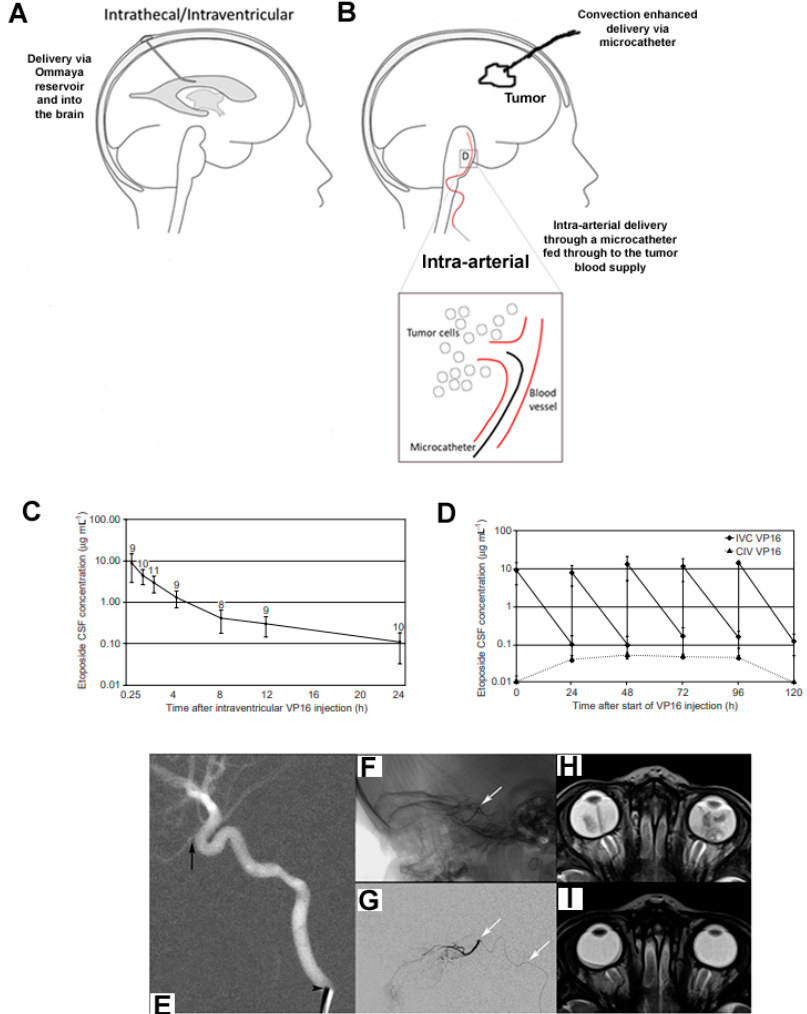
Figure 2. Intracranial drug delivery methods. Several methods can be utilized to maximize drug delivery to brain tumors: ( A ) intrathecal/intraventricular delivery via an Omaya reservoir (catheter) to administer drugs directly to the cerebrospinal fluid by the ventricle or subarachnoid space in the spine; ( B ) interstitial delivery using microcatheters and convection-enhanced delivery; ( C , D ) intra-